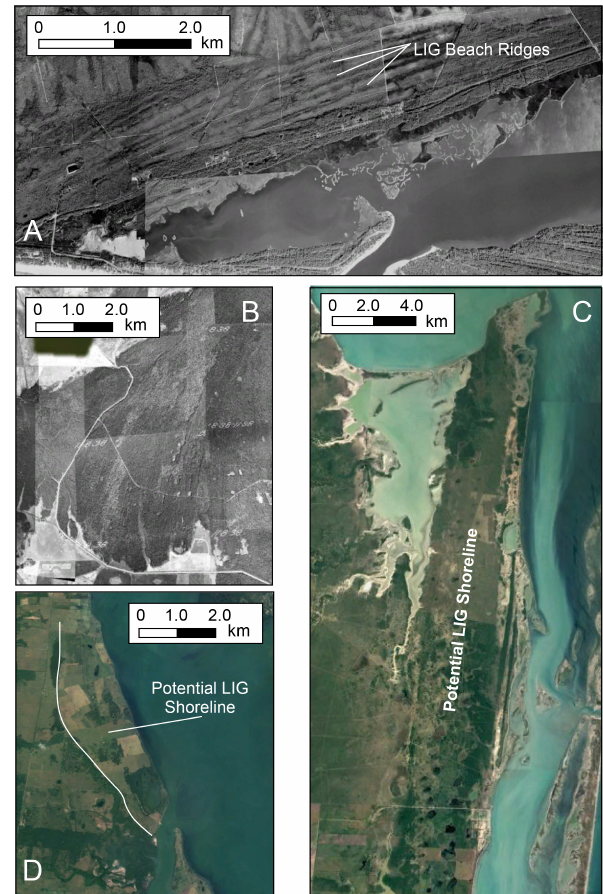
Figure 2. Aerial photographs illustrating well-preserved beach ridges on the LIG shorelines within (a) the Gulfport shoreline near the Apalachicola delta (Florida) (USGS, 1993) and (b) the Fannett (Texas) segment of the Ingleside shoreline (Texas Gen- eral Land Office, 1938) in addition to the potential LIG shoreline equivalents to the Ingleside and Gulfport shorelines (c) northeast of Soto la Marina, Tamaulipas, Mexico (Maxar Technologies), and (d) south of Tampico in Veracruz, Mexico (CNES/Airbus). Images from ©Google